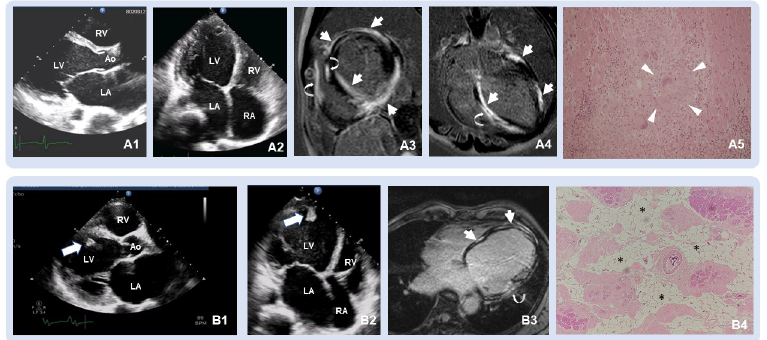
Fig 1. Pre-transplant multimodality imaging and post-transplant histopathological findings from two patients who were misdiagnosed. Multi-imaging modalities and histopathological findings of patient #2 (Table 3) with a post- transplant diagnosis of cardiac sarcoidosis and patient #5 (Table 3) with a post-transplant diagnosis of left dominant arrhythmogenic cardiomyopathy (LDAC). A1-2 , a transthoracic echocardiogram showing dilated left ventricle (LV) with reduced LV wall thickness and severe LV systolic dysfunction. A3-4 , cardiac MRI images showing extensive subepicardial late gadolinium enhancement of anterior and lateral walls and interventricular septum (arrows) and transmural late gadolinium enhancement of inferior wall (arrows) and late gadolinium enhancement of right ventricular free wall and septum (curved arrows). A5 , histological micrograph (x20) from an explanted heart showing noncaseating, multinucleated giant cell granuloma (arrow heads) involved left ventricular myocardium consistent with cardiac sarcoidosis. B1-2 , a transthoracic echocardiogram showing severe LV systolic dysfunction with apical thrombus (white arrows). B3 , a 4-chamber-view cardiac MRI image showing mid-wall late gadolinium enhancement of interventricular septum and LV apex (arrows) and severe myocardial thinning with late gadolinium enhancement of lateral wall (curved arrows). B4 , left ventricular histological micrograph showing fibroadipose replacement (asterisks) of the compacted myocardium consistent with arrhythmogenic cardiomyopathy.